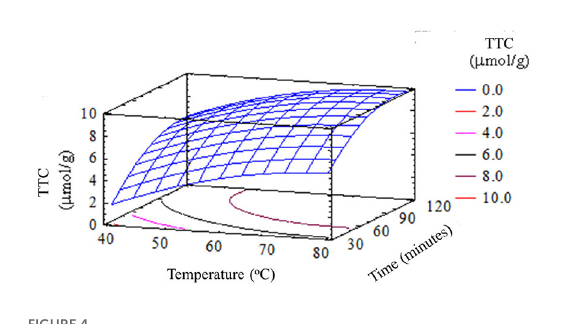
FIGURE4 Effect of extraction temperature and time on the TTC in garlic